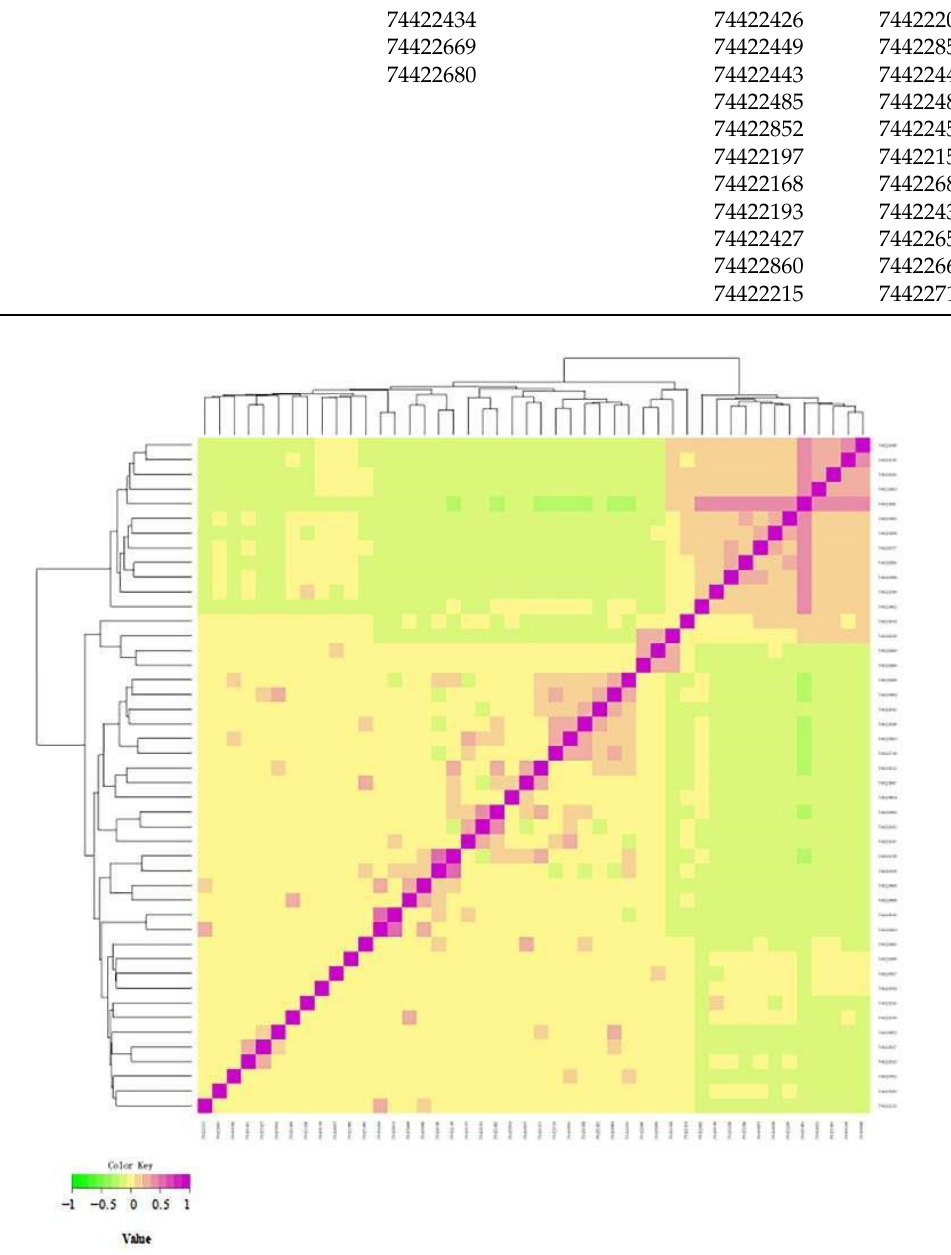
Figure 7. Visualization results of the genome kinship analysis. Note: This figure shows the genomic kinship coefficient between two individuals. The closer the color, the closer the kinship. The abscissa and ordinate indicate the individual IDs.